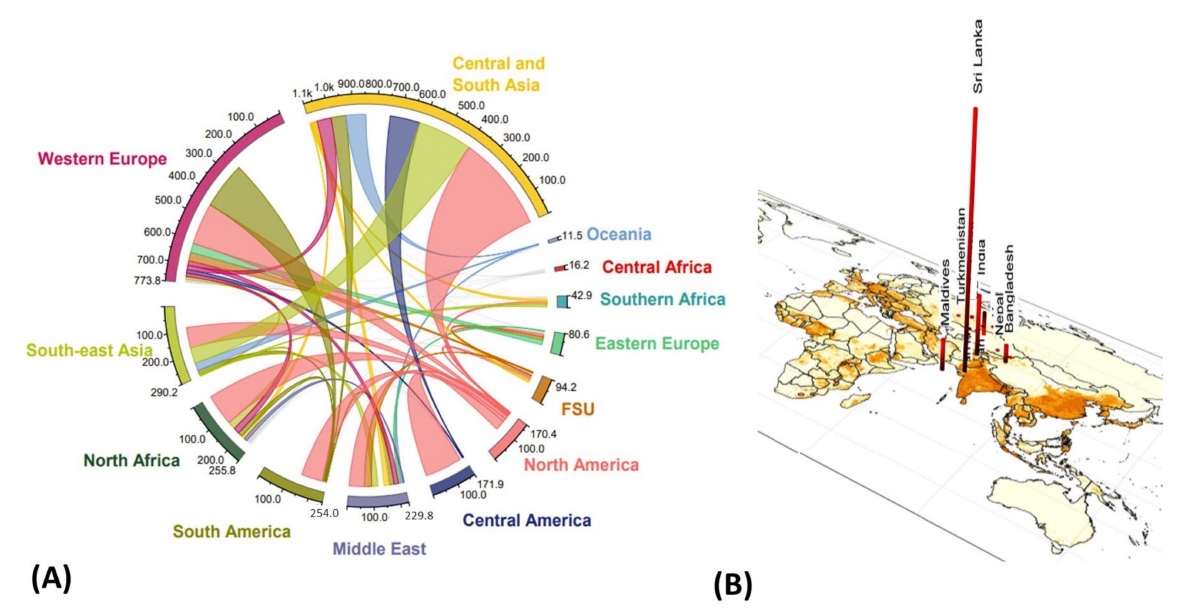
Figure 3. ( A ) Gross virtual water trade between world regions in the period 1995–1999 (Gm 3 ), ( B ) net virtual water imports of central and southern Asian countries (10 6 m 3 /yr).